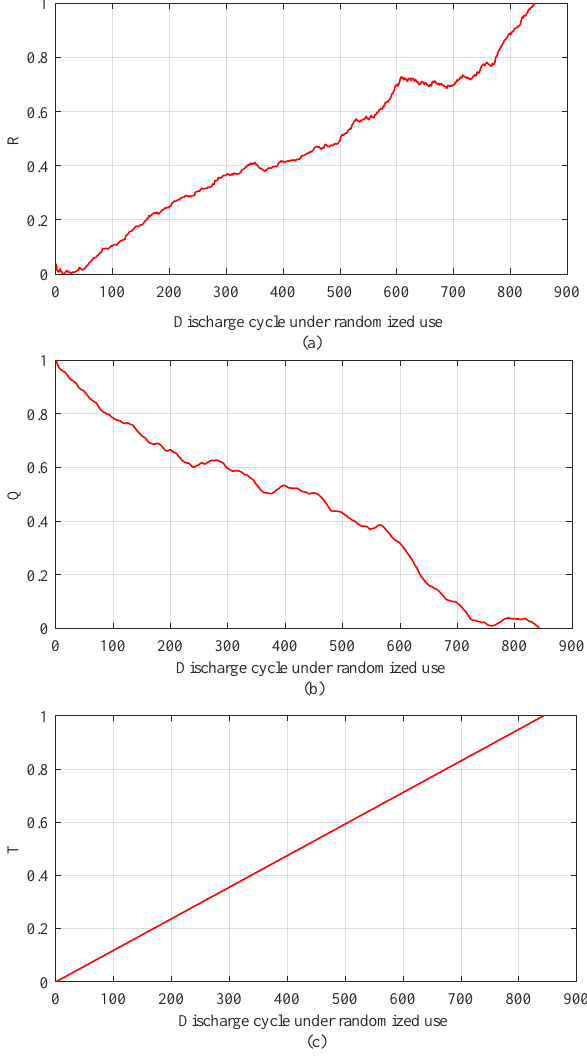
Figure 9. The indirect (health indicator) HIs extracted for battery RW3. ( a ) ˜ R ∗